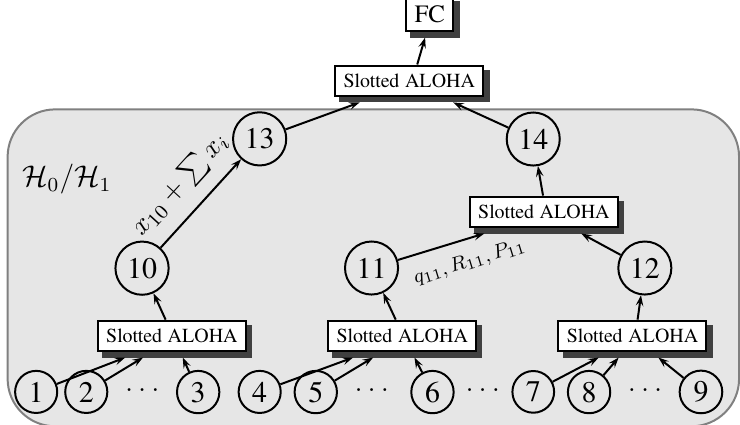
Figure 2. Detection architecture for tree-topology